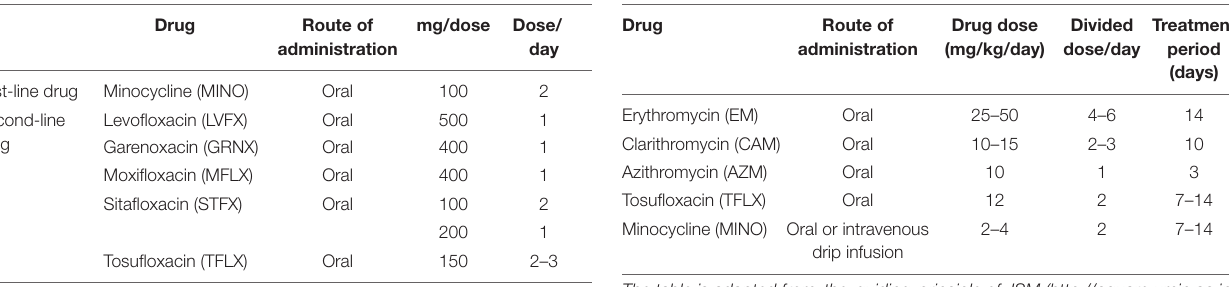
The table is adapted from the guiding principle of JSM (http://square.umin.ac.jp/ jsm/shisin.pdf).